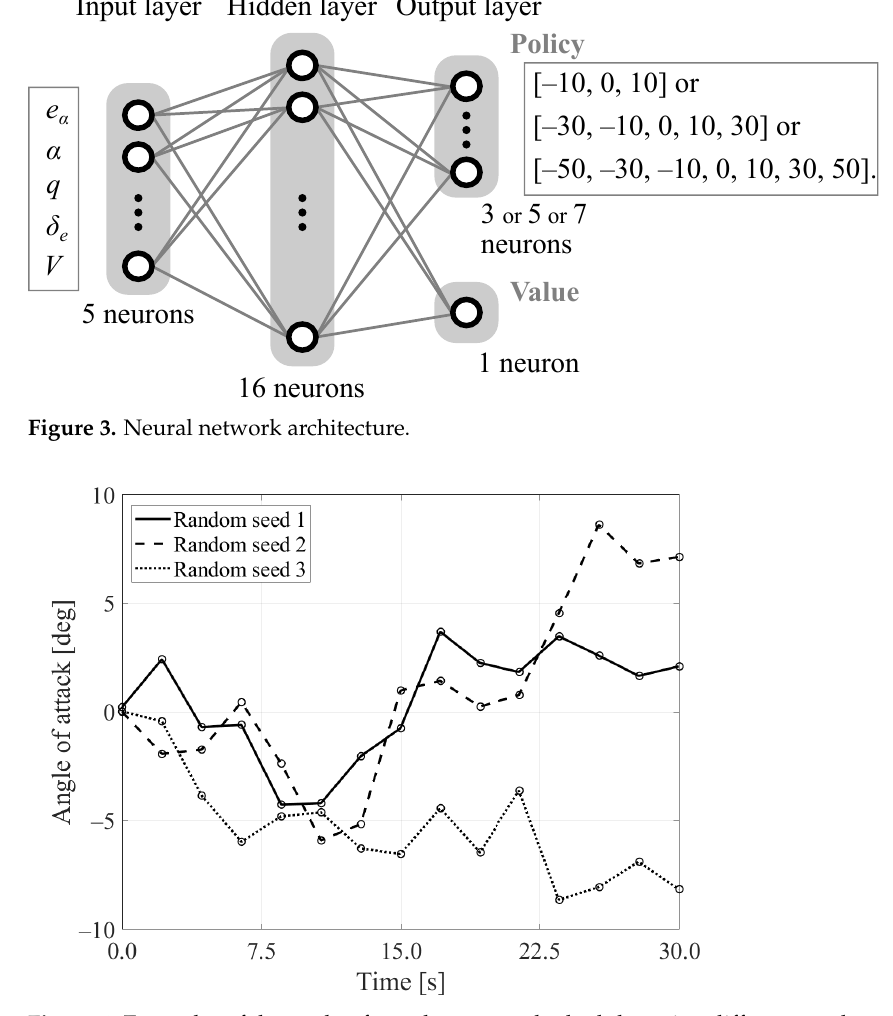
Figure 4. Examples of the angle-of-attack command schedules using different random